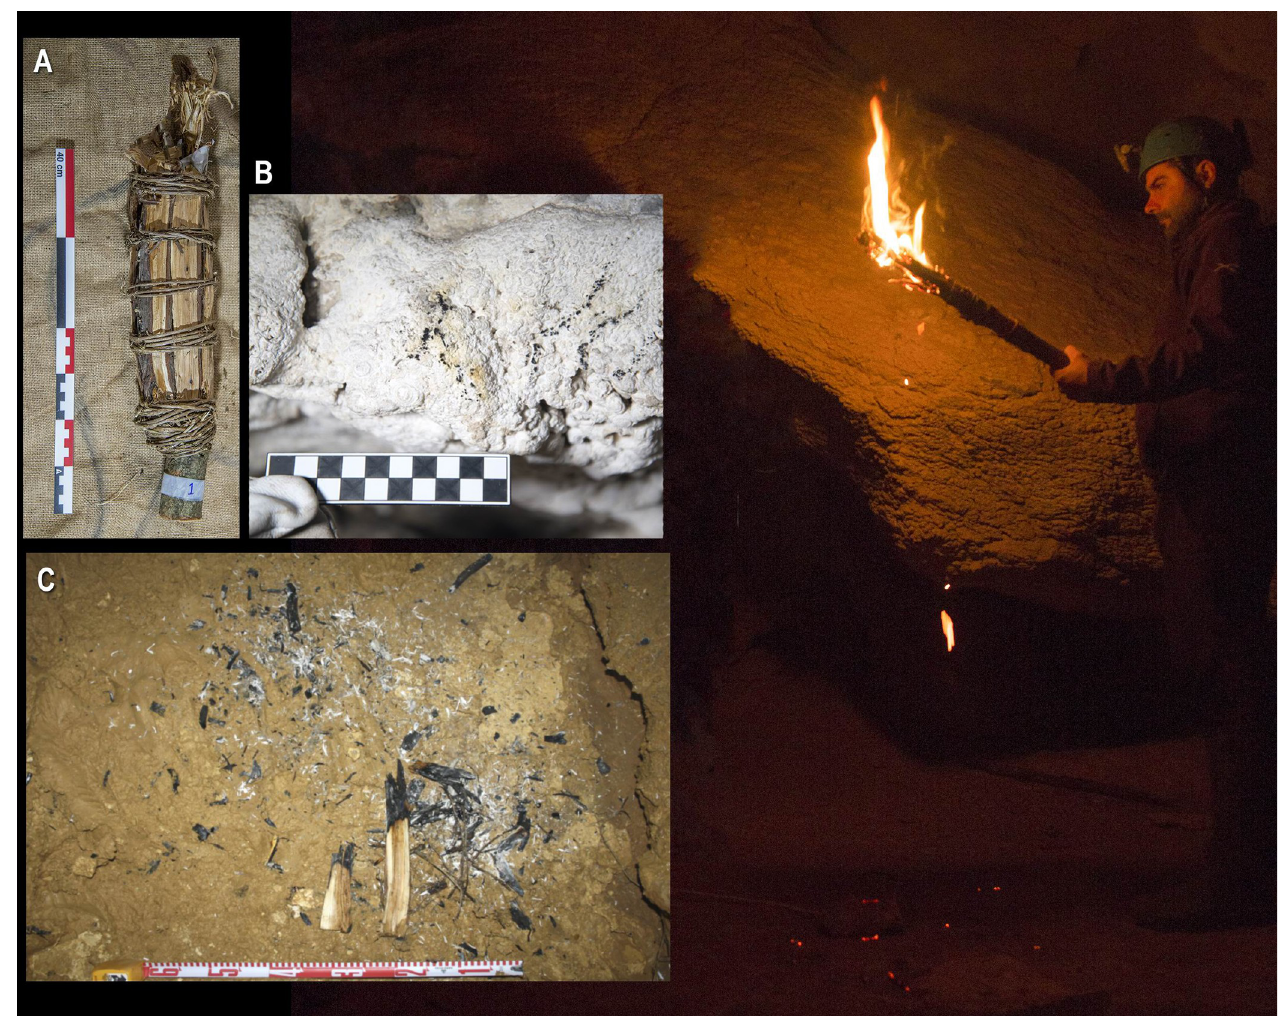
Fig 6. Photograph of Torch 1 in the experiment. Note how charred wood fell from it during its use. A. Torch 1 before being lit. B. Combustion marks left by the torch on the cave walls. C. Remains fell from the torch on the cave floor when it was being used.